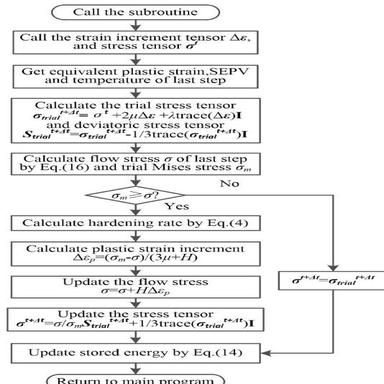
Flowchart for implementation of the constitutive model and stored energy model. I is the identity matrix, trace (D) is equal to (D11+D22+D33).